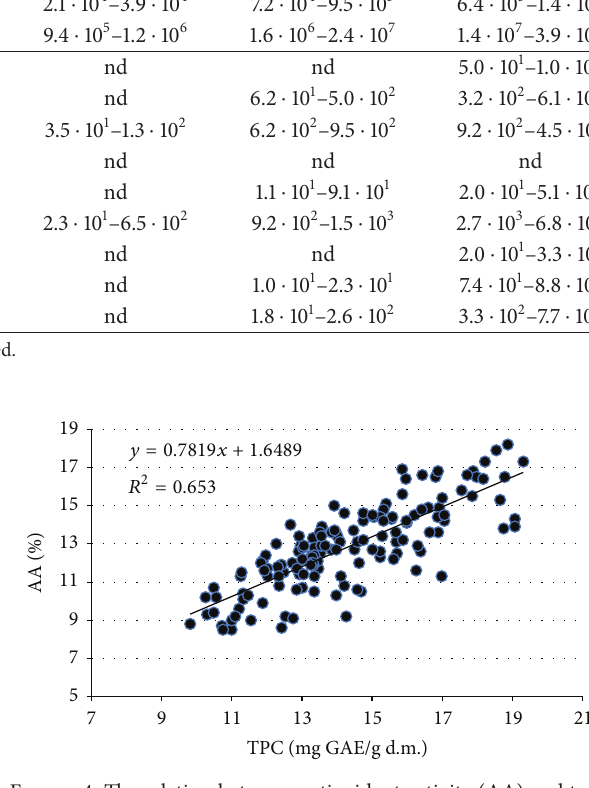
Figure 4: The relation between antioxidant activity (AA) and total phenolics content (TPC) in wheat